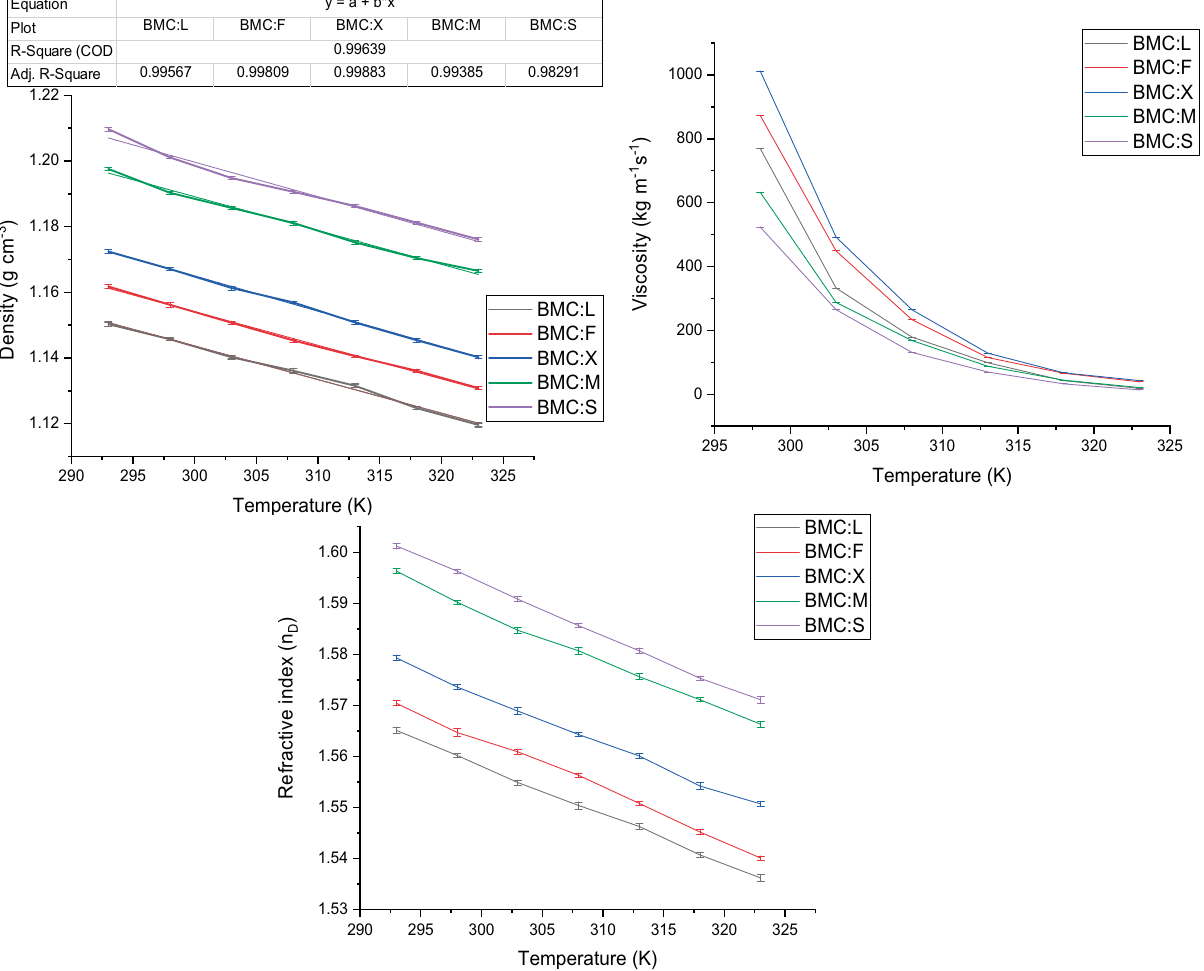
Figure 1. Temperature dependence (273–373 K) of density ( A ), viscosity ( B ) and refractive index ( C ) for all NADES formed by combining Benzyl trimethyl ammonium chloride (BMC:L) with Lactose, Fructose, Xylose, Maltose and Sucrose in the temperature range of 273–323